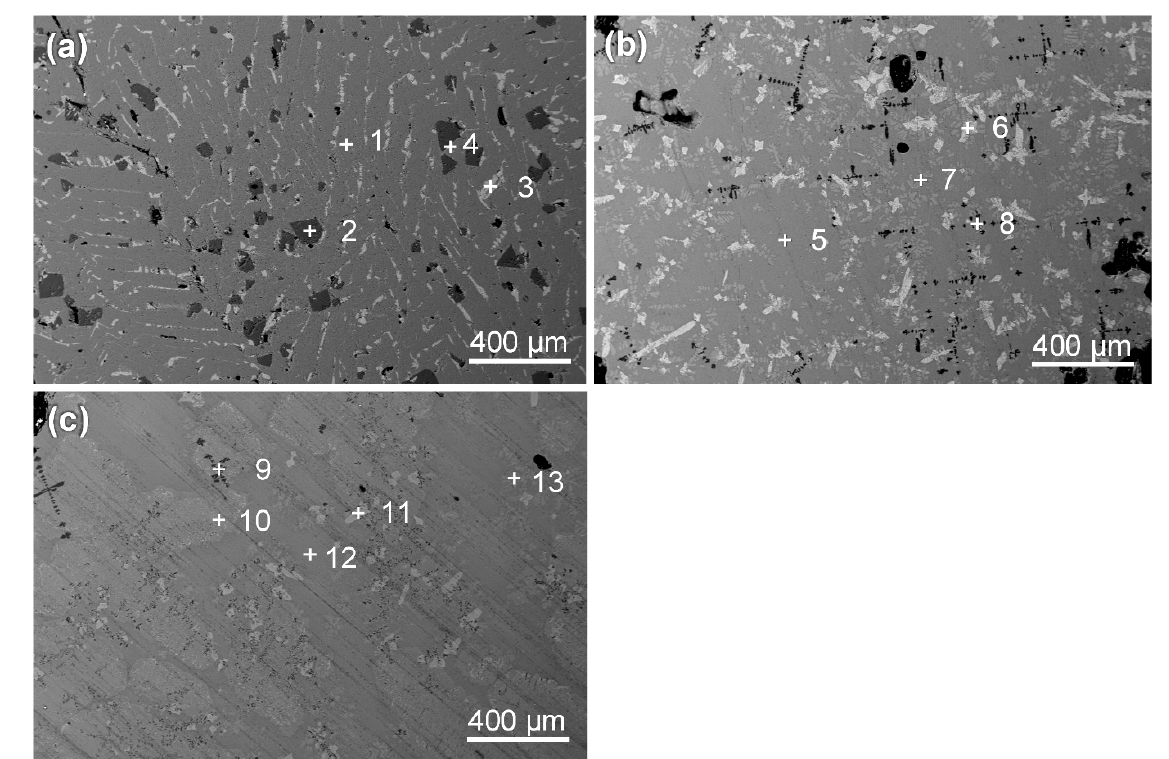
Figure 7. Morphologies of slag samples with different basicity levels ( w (TiO 2 ) = 5%, 1310 °C): ( a ) Slag B1, R = 2; ( b ) Slag A3, R = 6; ( c ) Slag B3, R = 10.